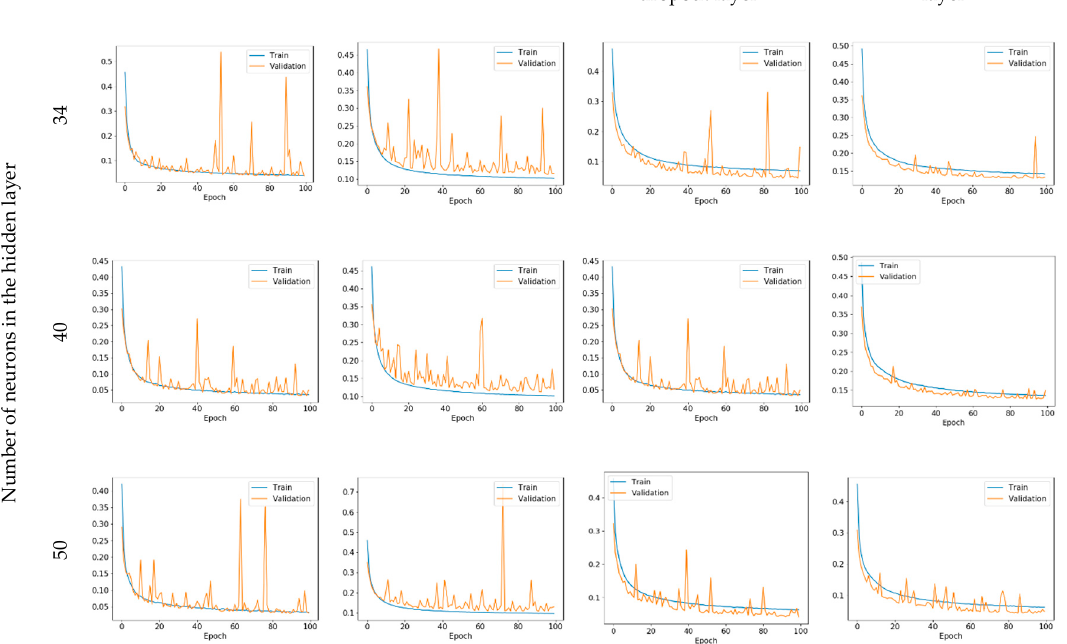
Figure 6. Learning curves for various two-layer MLP configurations—training set scores in blue, validation set scores in orange. The plots in the first two and second two columns correspond to architectures without and with the dropout layer, respectively. The curves in columns 1 and 3 were obtained for the noise-free training data, whereas in columns 2 and 4 for the data corrupted with Gaussian noise.